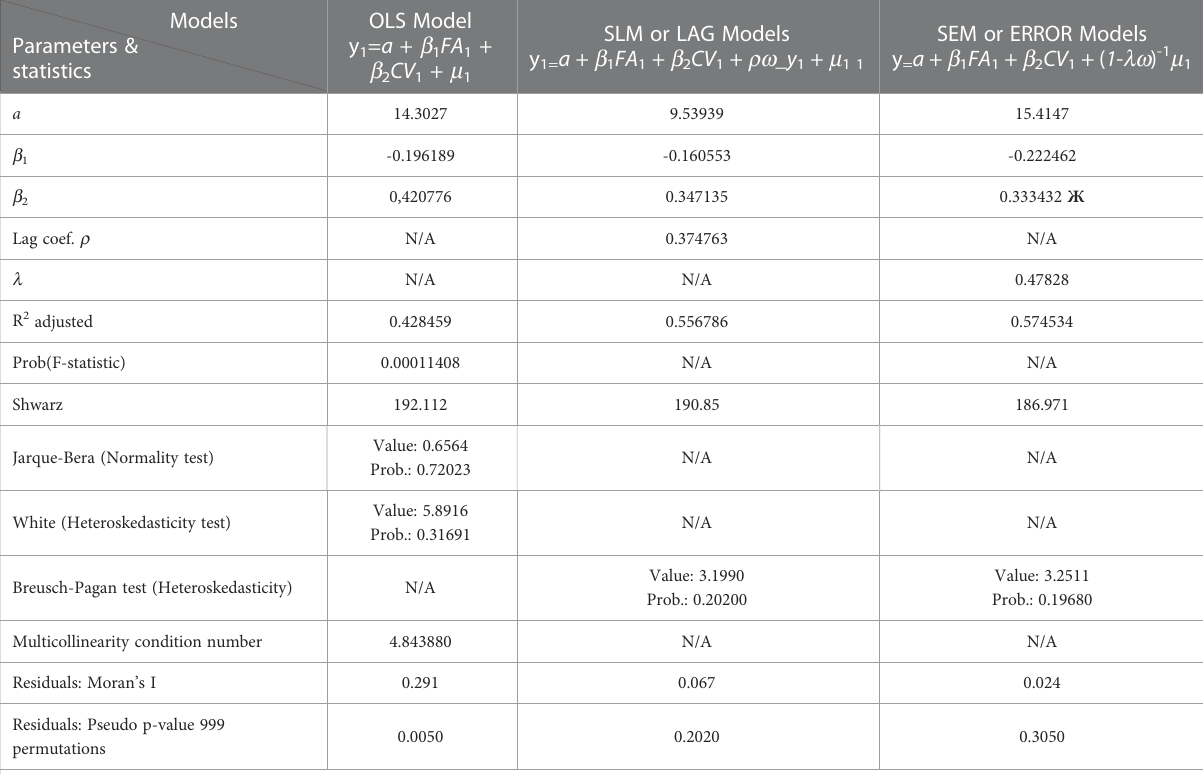
TABLE 3 Estimation of OLS-SLM-SEM models.